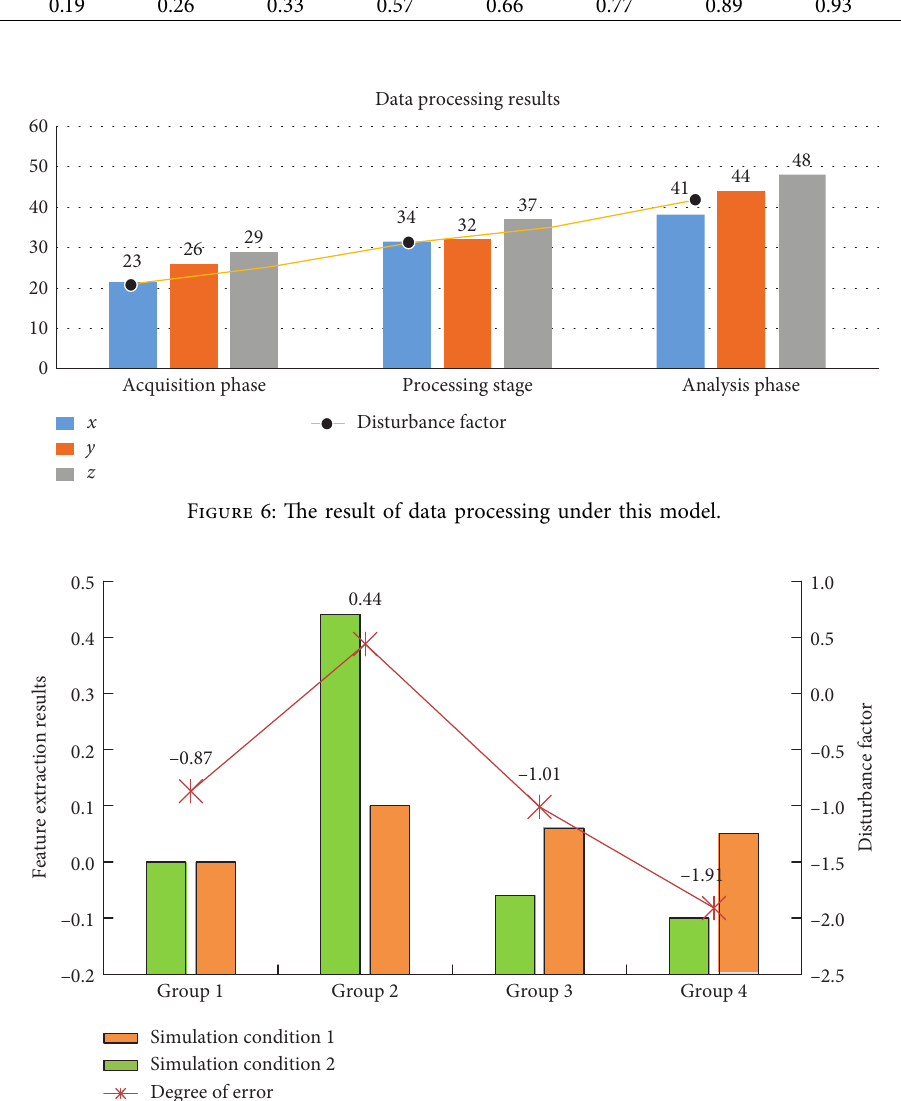
Figure 7: Evaluation results of the data obtained by this model.